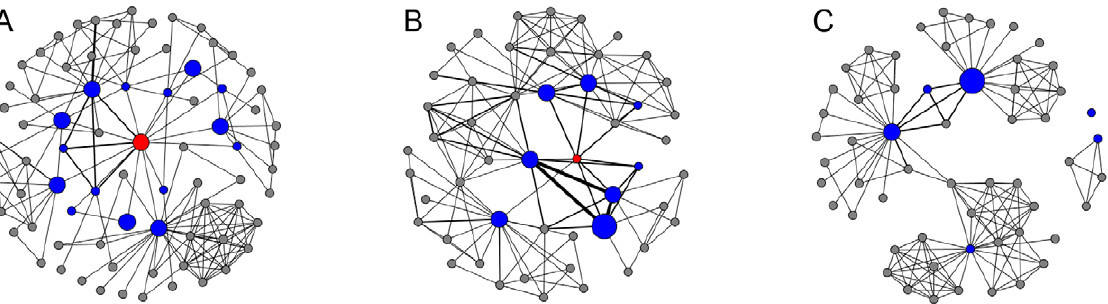
Figure 3. Illustration of egocentric scientific collaboration network evolution. (A) and (B) are the T-2 egocentric scientific collaboration networks of the same eminent scientist in two consecutive non-overlapping time windows (window size=5 years). The red node is the center of the network, i.e. the superstar. The blue and gray nodes are the first and second tier neighbors of the superstar in that particular time window. The sizes of the nodes and thickness of the edges in the figure are proportional to the numbers of journal articles published by the scientists and the numbers of journal articles co-authored by the pairs of collaborations. (C) is the T’-2 network after the superstar’s death. The blue nodes are the dead superstar’s first tier neighbors in the last window before his death (the former collaborators). The gray nodes are the neighbors of the former collaborators in the first window after the superstar’s death.